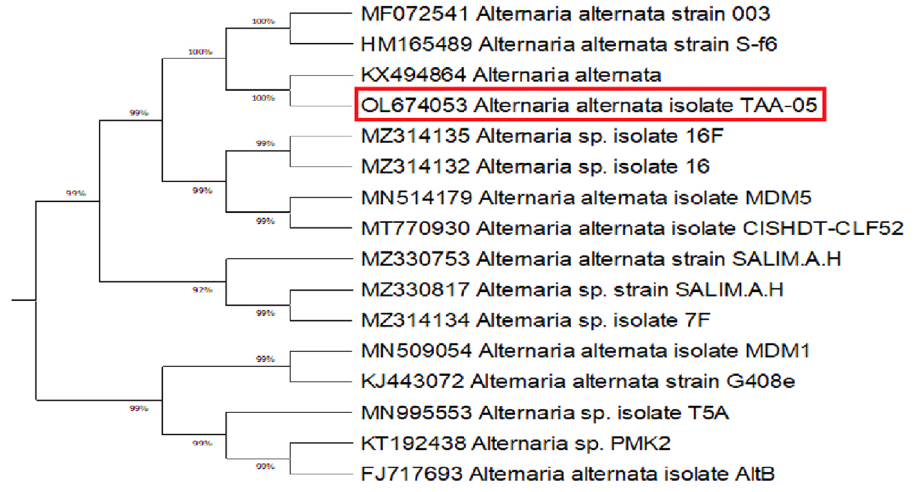
Figure 3. Constructed phylogenetic tree based on 16 most parsimonious 18SrRNA sequences. The Egyptian fungal isolate is Alternaria alternata TAA-05 (OL674053).